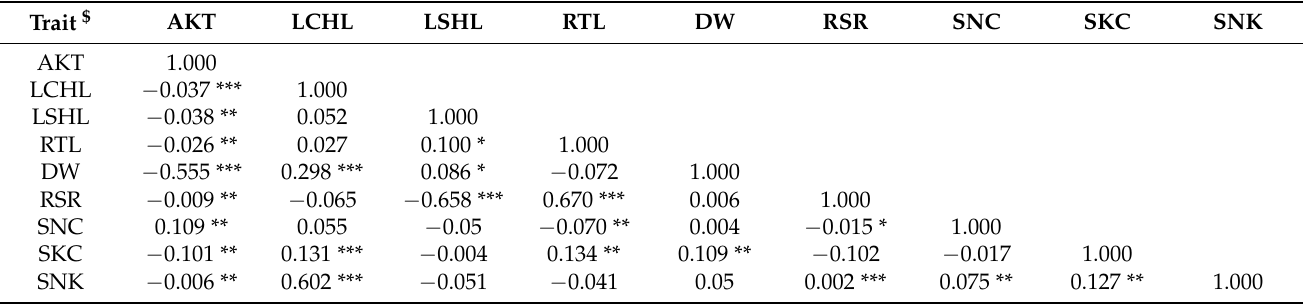
Table 2. Pearson correlation matrix of morphological and physiological traits measured in response to alkaline stress at seedling stage in Cocodrie × Dular RIL